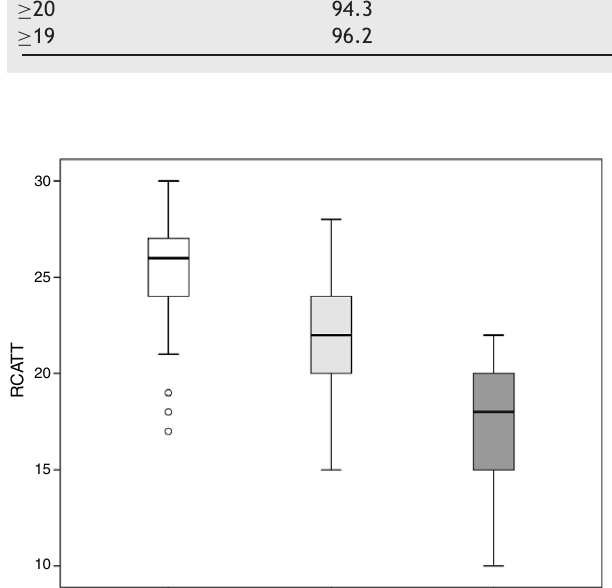
Figure 3 Total score values of Rhinitis Control Assessment Test (RCAT) discriminated by the medical opinion about the control of nasal symptoms as controlled (white), partially con- trolled (light gray), and uncontrolled (dark gray).